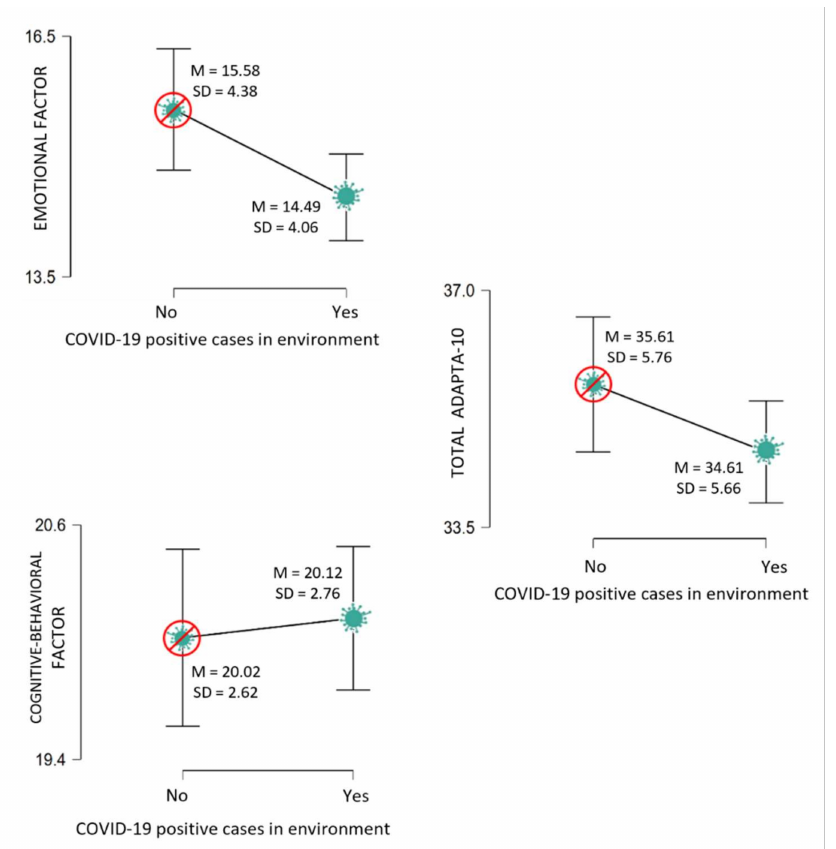
Figure 1. Adaptability to change by presence of positive close COVID-19 cases. Descriptive plots.